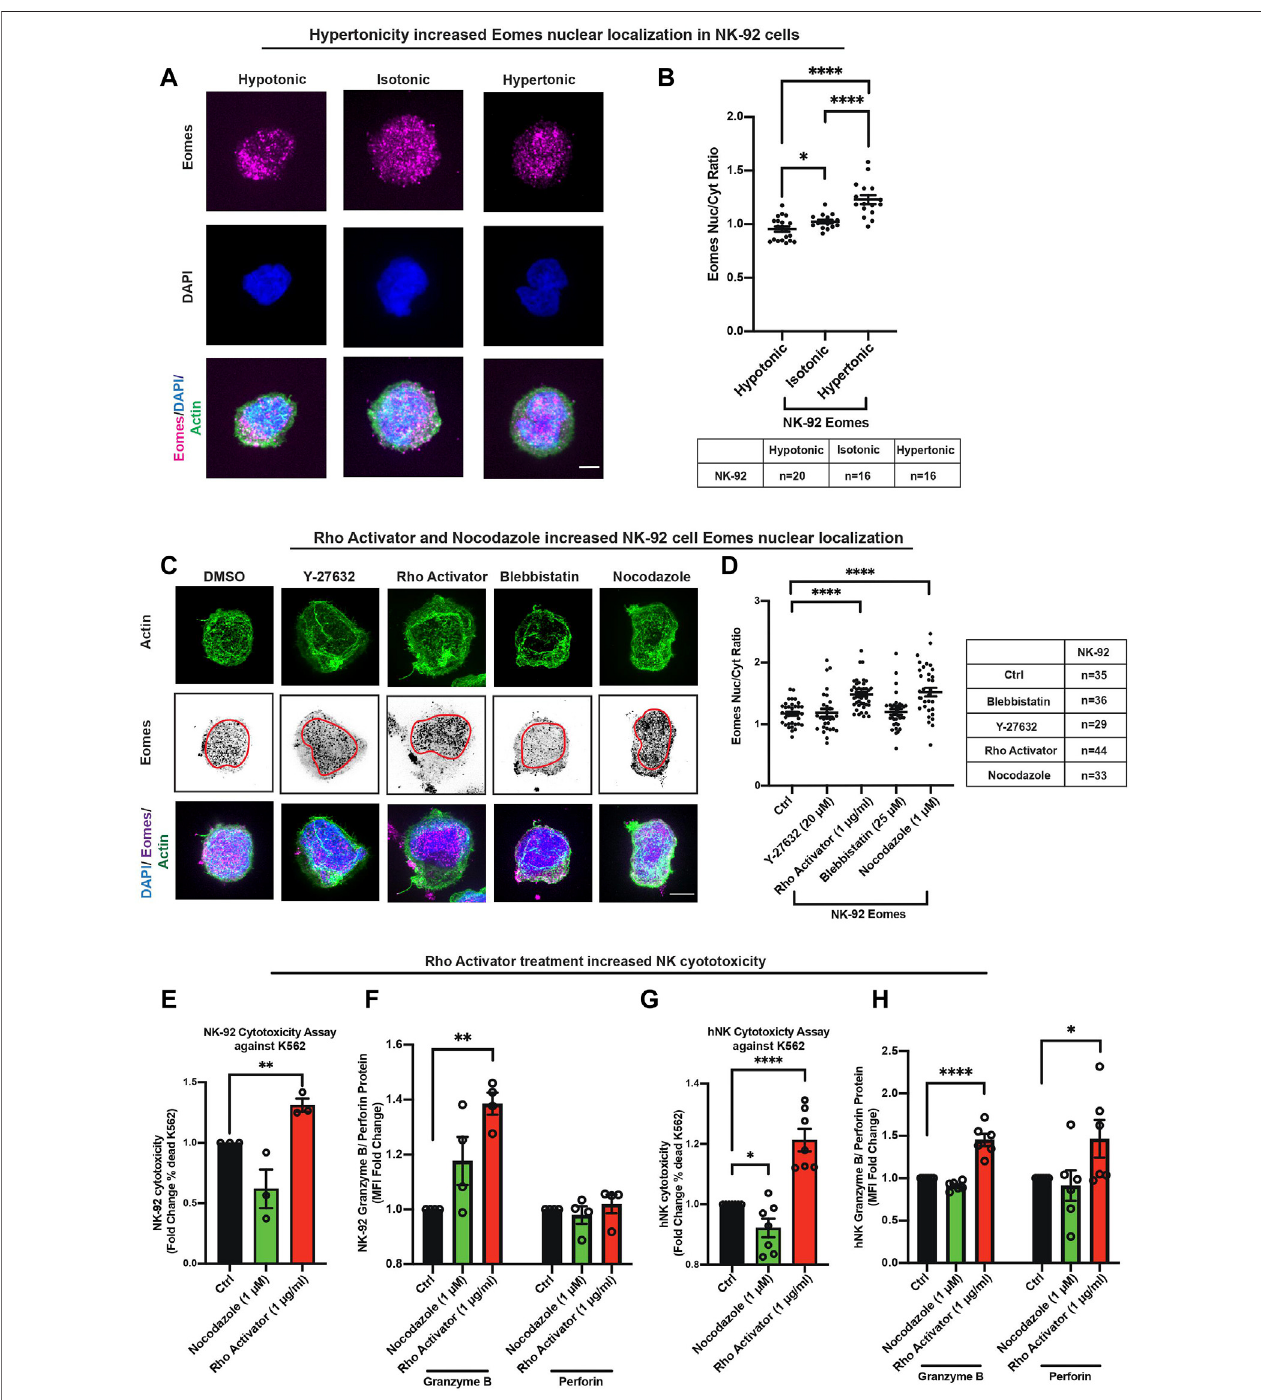
FIGURE 4 | Eomes is the fi rst transcription factor identi fi ed to respond to cellular contractility . (A,B) Hypertonic treatment signi fi cantly increased NK-92 Eomes nuclearlocalization.Representativeimagesandquanti fi cationofEomesintracellularlocalisationafter30 minoftonicitytreatment.Thegraphrepresentsmeans±SEM, n istabulatedbelowthegraph.Scale bar=5 μ m.Unpairedstudents t -test wasused. (C,D) Representative imagesand quanti fi cation ontherightshow increasednuclear localisation of Eomes with Rho activator and nocodazole treatment. The graph represents means ± SEM, n is tabulated beside the graph. Scale bar = 5 μ m. Unpaired students t -test was used. (E,G) Increased cellular contractility due to treatment with Rho activator enhanced NK-92 and hNK cytotoxicity (re fl ected as percentage killing) against model target K562 cells, effector (NK): target (K562) ratio was 3:1 for NK-92 and 1:1 for hNK cells. n = 3 for NK-92 and n = 7 for hNK, representativeofthreedonors. (F,H) RhoactivatorincreasedtheproductionofgranzymeBinNK-92 (F) andhNK (H) cellscoculturedwithK562cells,whereasonlyhNK cellsshowedanincreaseinperforinexpressionwithRhoactivator treatment. n =4forNK-92cellsand n =6independentexperiments representative ofthreedonorsfor hNK cells. All graphs are represented by means ± SEM and unpaired students t -test was used.